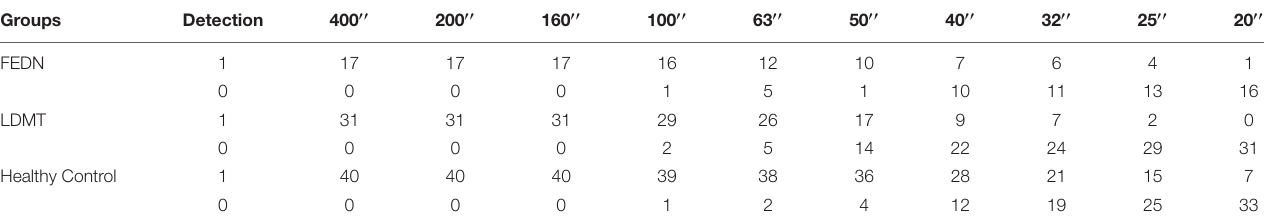
TABLE 2 | Number of subjects that detected (“1”) or did not detect (“0”) the stereo pattern at each angle of stereopsis in the FEDN, LDMT and healthy control groups. Groups